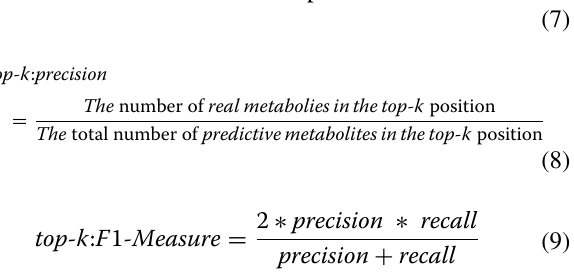
Table 2 Prediction results of the metabolites for test set 1